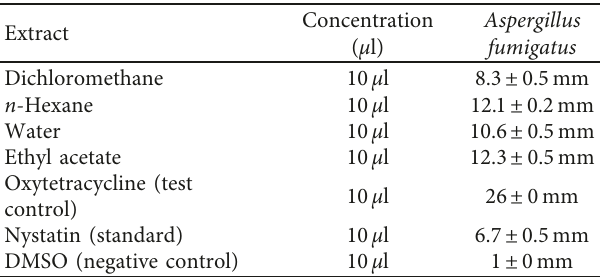
Table 2: Result of antifungal activity of Veronica biloba .